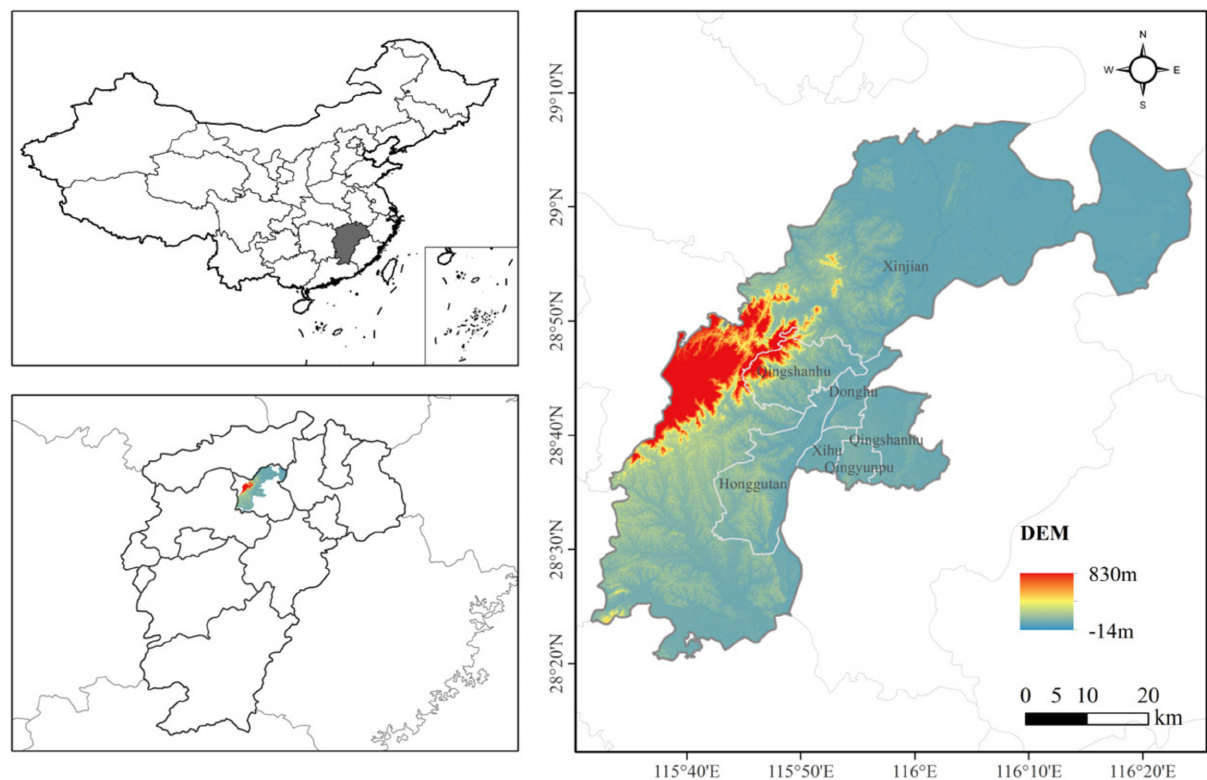
Figure 1. Overview of the study